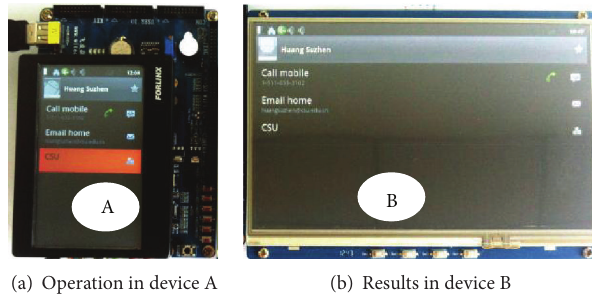
Figure 11: Resources in different